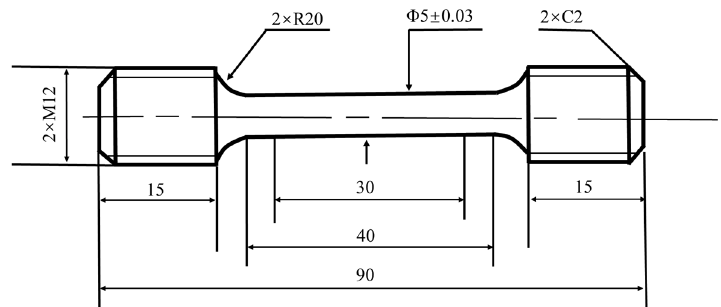
Figure 2. High temperature tensile sample.